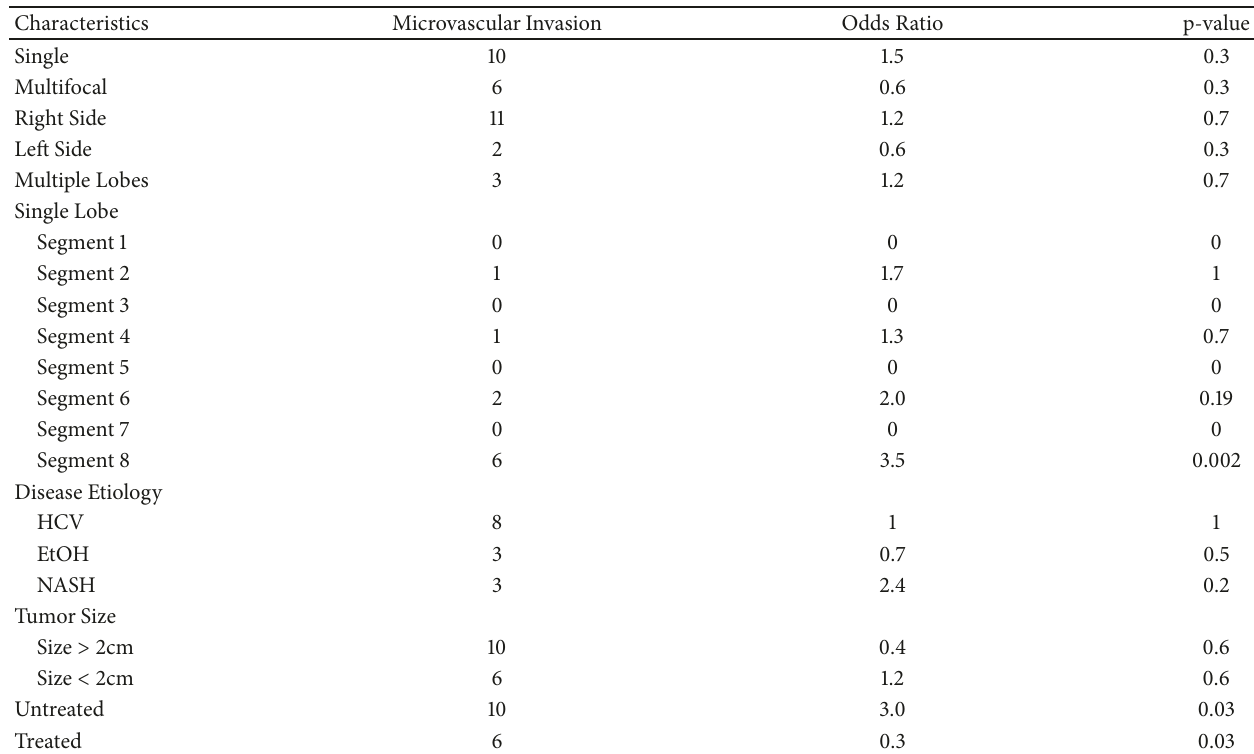
Table 2: Odds ratios of microvascular